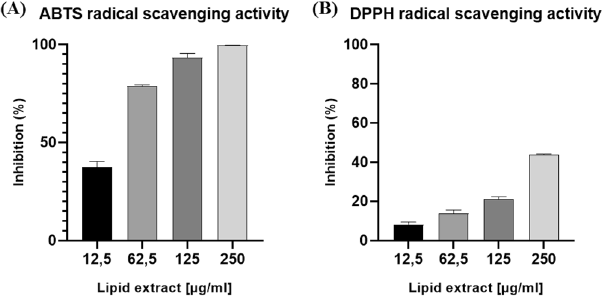
Figure 9. Percent inhibition as a function of the concentration of the lipid extracts of Chlorococcum amblystomatis after 120 min of ABTS •+ ( A ) and DPPH • ( B ) radical scavenging